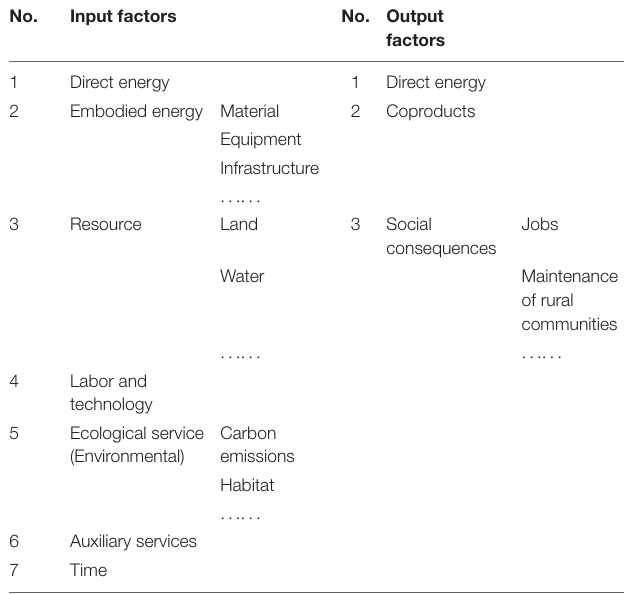
TABLE 1 | Common input and output factors for EROI analyses.